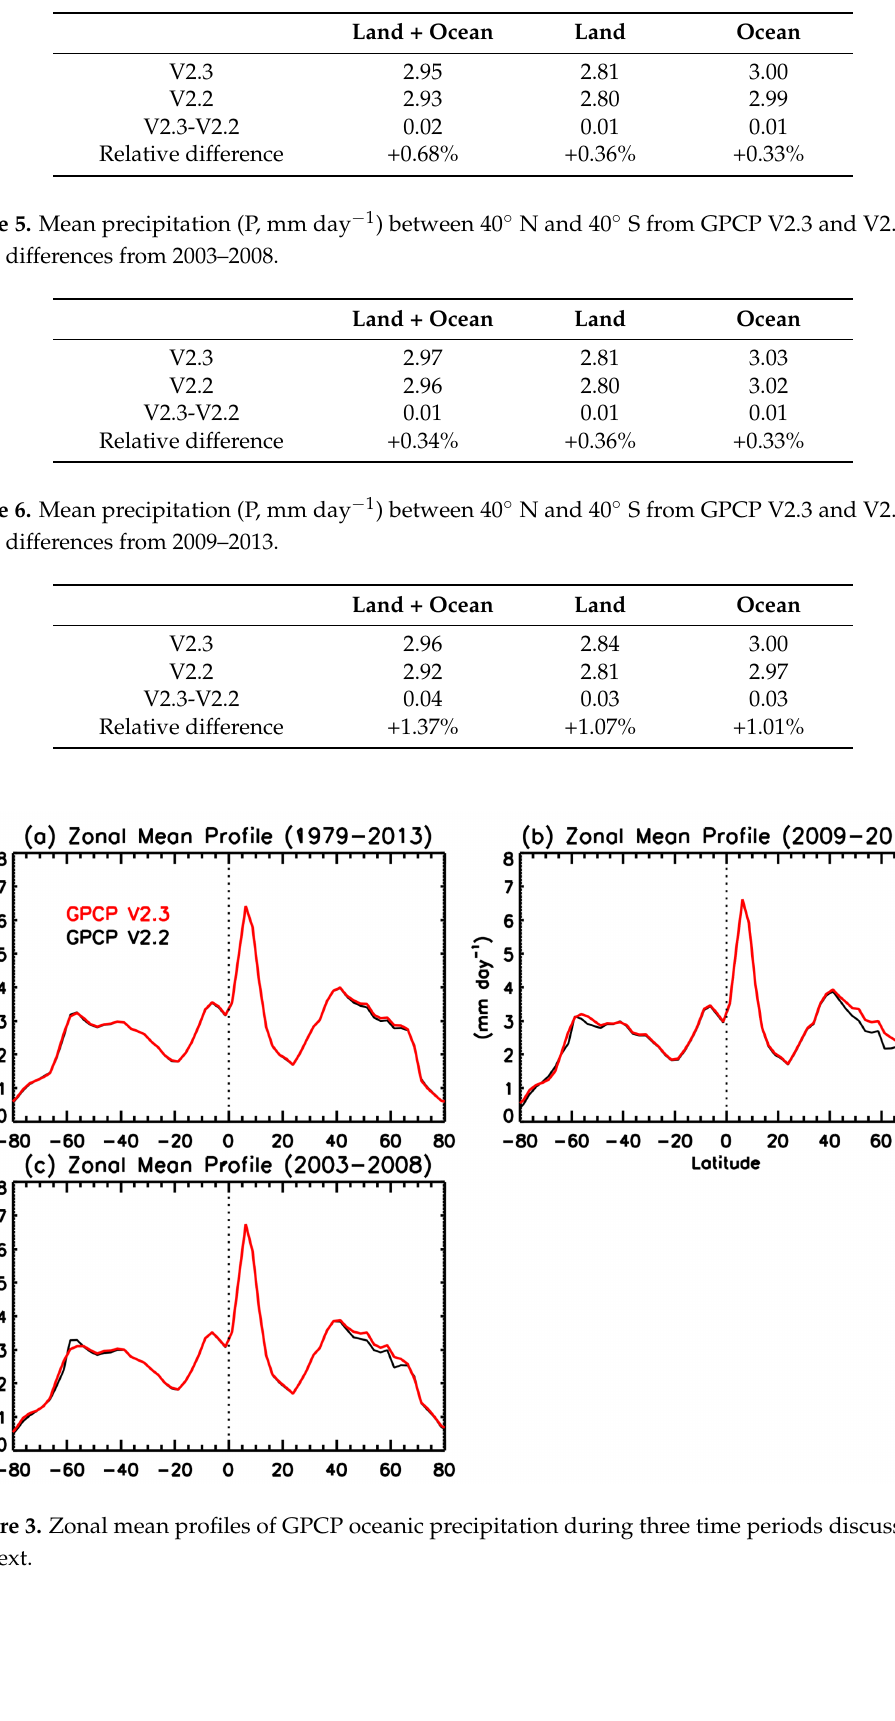
Table 4. Mean precipitation (P, mm day − 1 ) between 40 ◦ N and 40 ◦ S from GPCP V2.3 and V2.2 and their differences from 1979–2013.